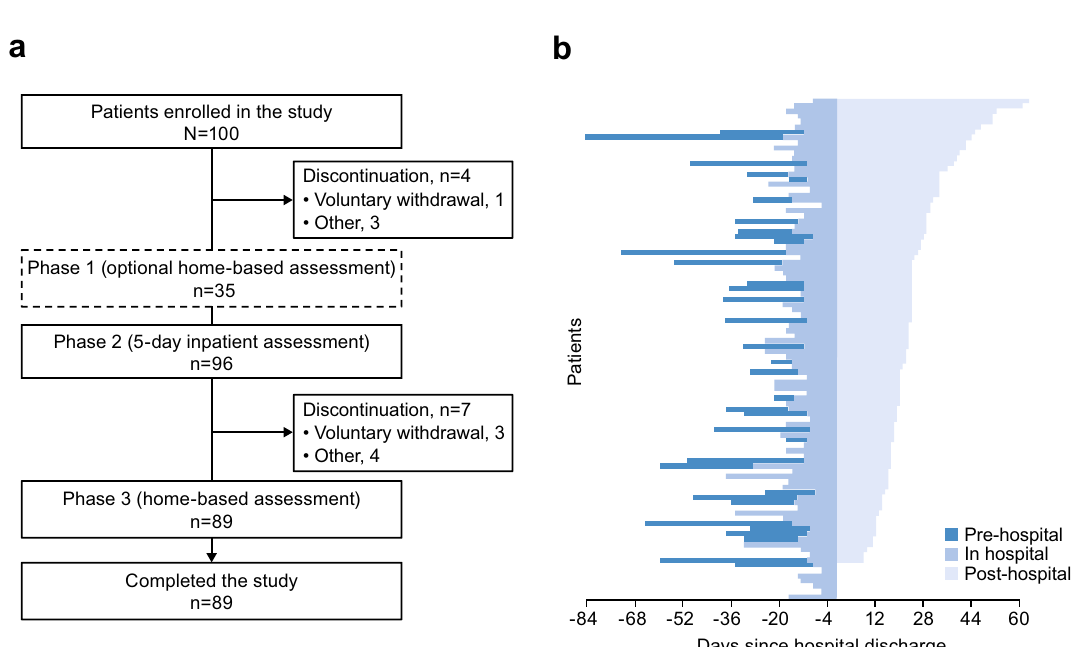
Figure 3. Patient flow. ( a ) Study flow diagram and ( b ) individual patient participation. Patients wore the smartwatch during the 1-month pre- or post-hospitalization periods and during the 5-day inpatient